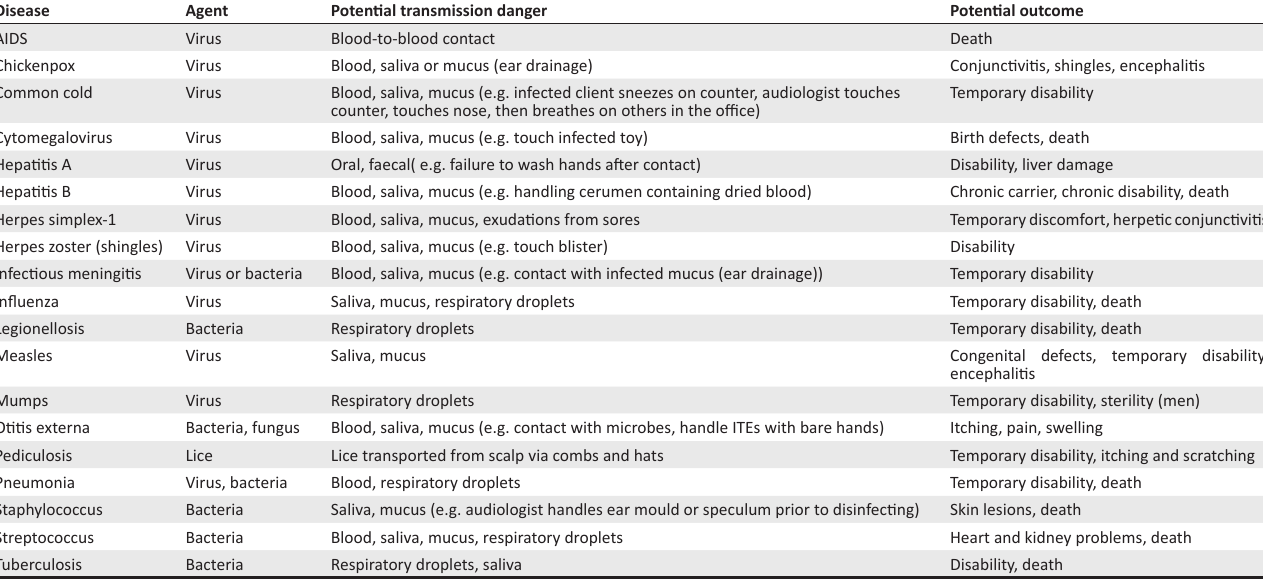
TABLE 1: Infectious diseases important to audiology.